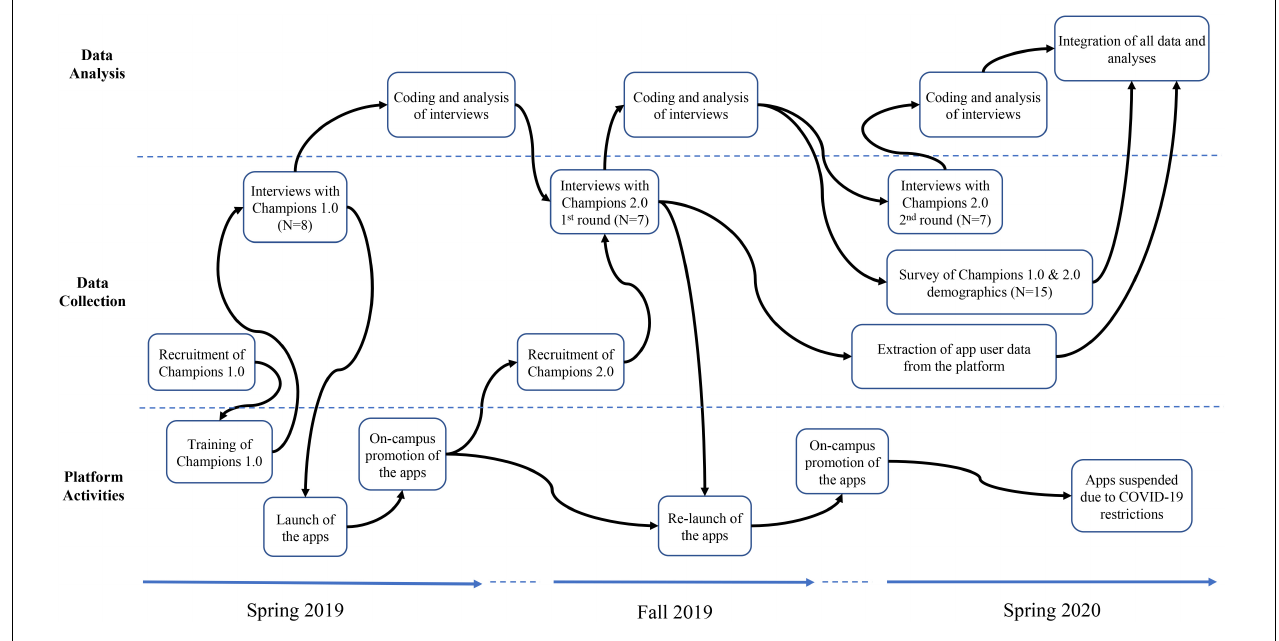
FIGURE 1 | Overview of data